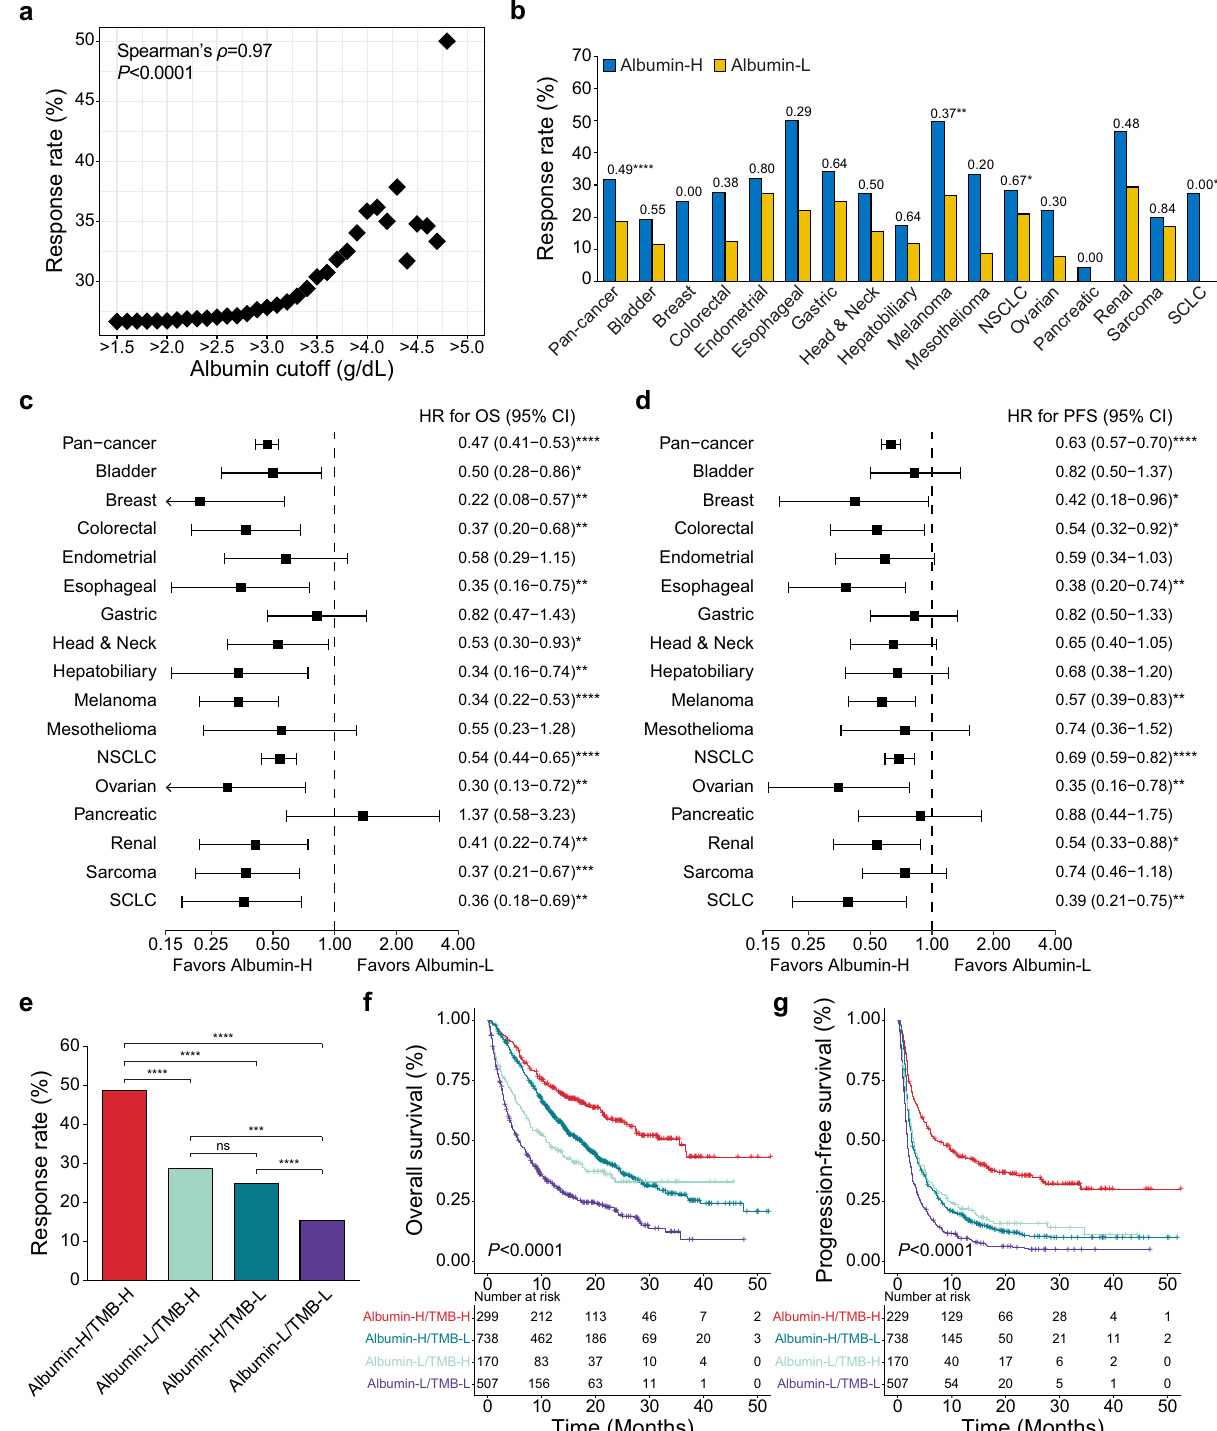
Fig. 1 Effects of pretreatment serum albumin on outcomes in patients following immune checkpoint blockade treatment. a Radiographic response rate as a function of serum albumin level (pretreatment measurement prior to fi rst infusion). b Pan-cancer and subgroup analyses comparing radiographic response rates between the albumin-high (Albumin-H) and -low (Albumin-L) groups. Odds ratios and χ 2 or Fisher ’ s exact tests P -values for each comparison are presented. * P ≤ 0.05 ** P ≤ 0.01 **** P ≤ 0.0001. Pan-cancer and subgroup analyses of c overall survival (OS) and d progression-free survival (PFS). All hazard ratios (HRs) and 95% con fi dence intervals (CIs) were calculated by univariable analysis. P -values were generated by the two-sided log-rank test. * P ≤ 0.05 ** P ≤ 0.01 *** P ≤ 0.001 **** P ≤ 0.0001. e Combined effects of serum albumin and tumor mutational burden (TMB) on radiographic response rate. P -values were generated by the χ 2 test. ns not signi fi cant * P ≤ 0.05 ** P ≤ 0.01 *** P ≤ 0.001 **** P ≤ 0.0001. Kaplan – Meier plots show the combined effects of serum albumin and TMB on f OS and g PFS. P -values were generated by the two-sided log-rank